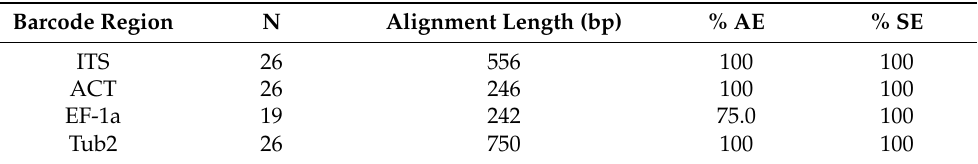
Table 4. Efficiency of PCR amplification and sequencing for Colletotrichum specimens for four DNA barcode regions. Barcode Region